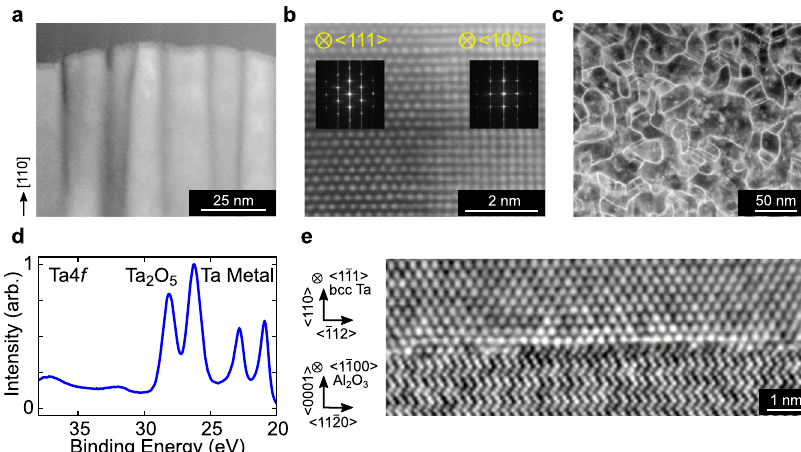
Fig. 3 Microscopy and spectroscopy of tantalum fi lms. a STEM image of the tantalum fi lm, showing single-crystal columns with the growth direction oriented along the [110] axis. b Atomic-resolution STEM image of an interface between two columns, viewed from 1 (cid:1) 11